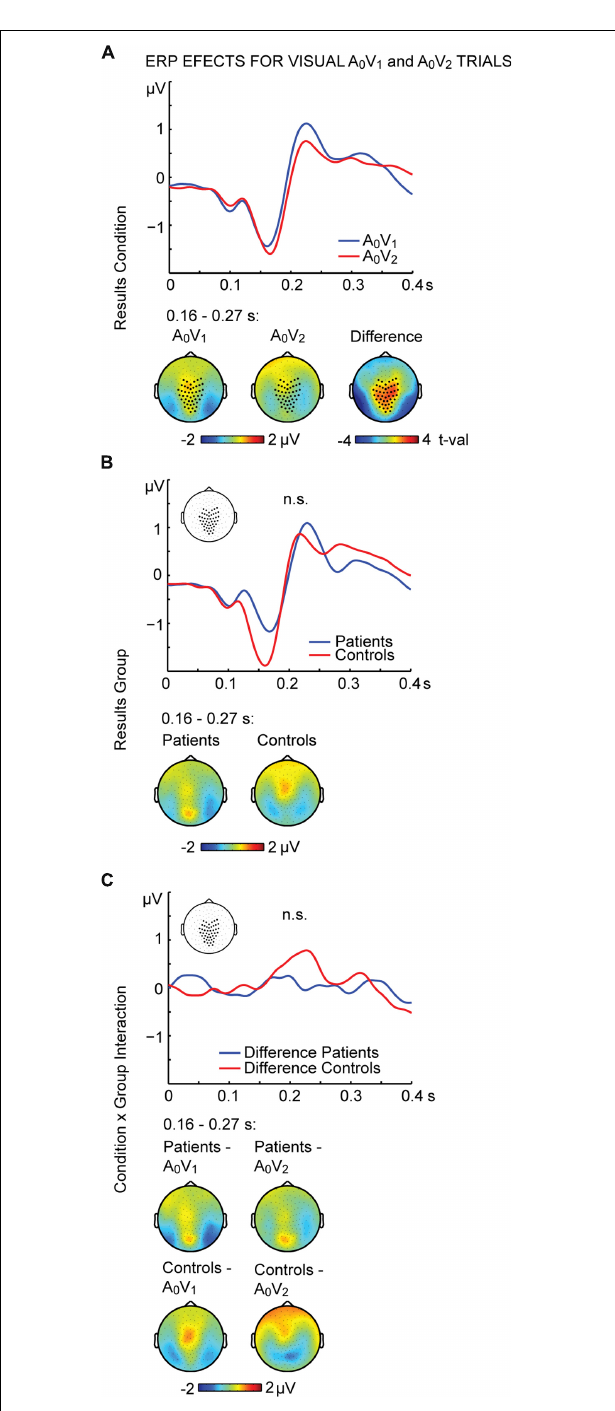
FIGURE 3 | ERP effects of visual A 0 V 1 and A 0 V 2 trials. Outcome of the non-parametric tests with cluster-based correction for multiple comparisons between Conditions (A 0 V 1 vs. A 0 V 2 ) between Groups (SCZ vs. HC), and for the Condition differences between Groups (i.e., the Condition by Group interaction). The upper planes in panels (A–C) illustrate significant main effects of Condition (A) , the ERP results for Group (B) and the Condition by Group interaction (C) . The lower planes depict topographic maps for the observed effects with highlighted significant cluster electrodes. Time-point 0 indicates the onset of the first visual